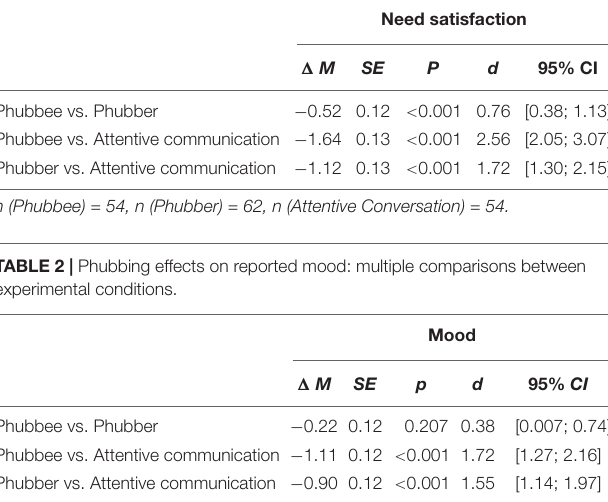
Need satisfaction SE